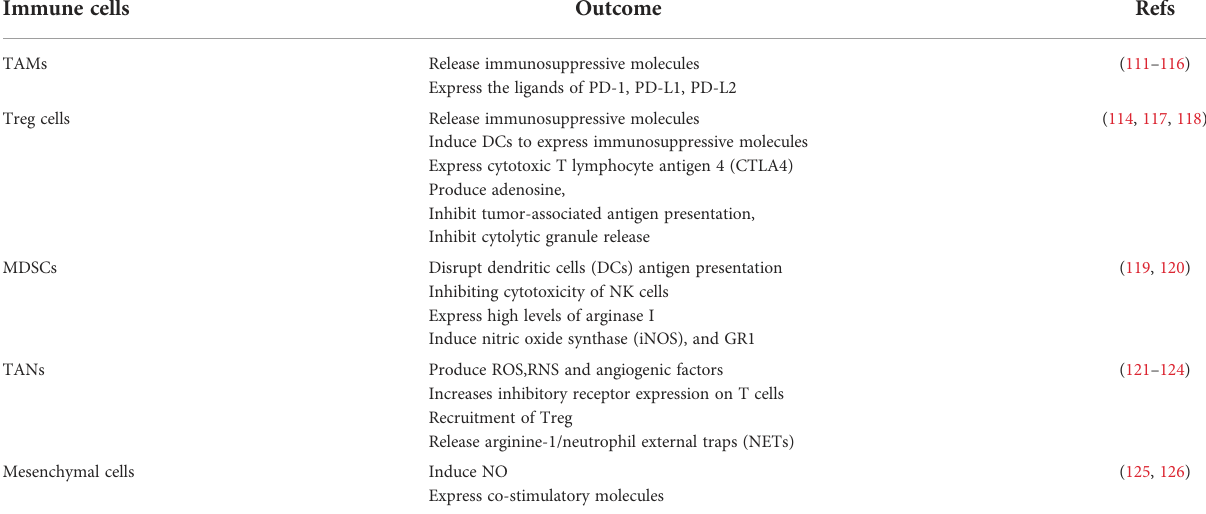
TABLE 2 Immune cells in chronic in fl ammation. Immune